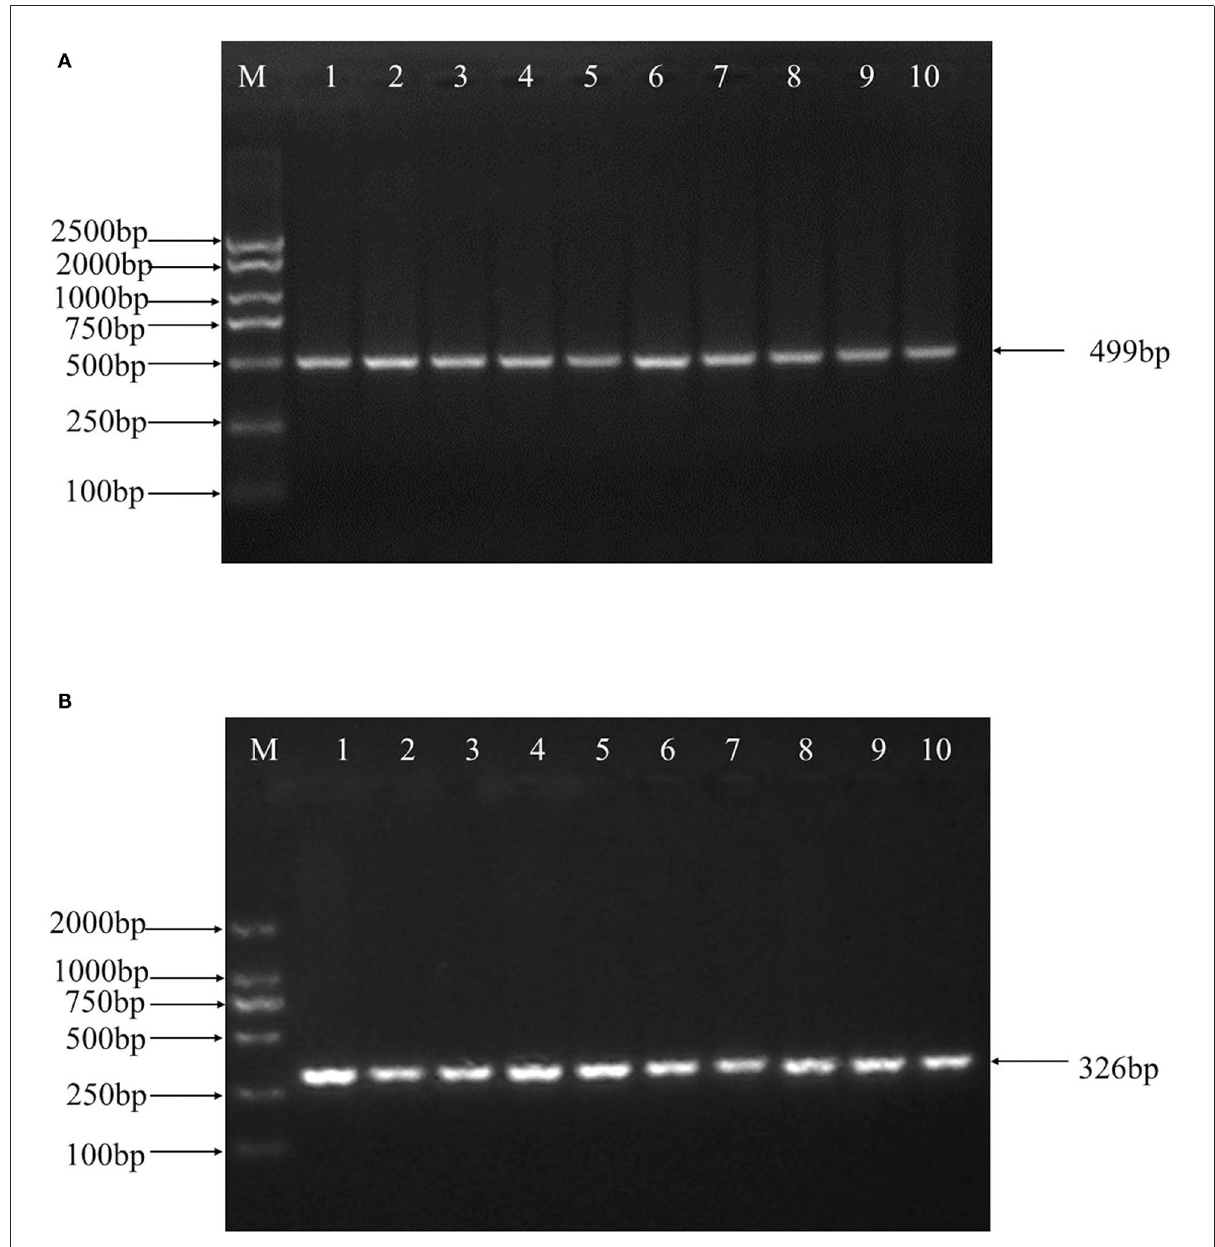
FIGURE1 PCR amplification of ovine SHISA3 (A) and RFC3 (B) genes target fragment. M, DNA marker; 1–10, PCR